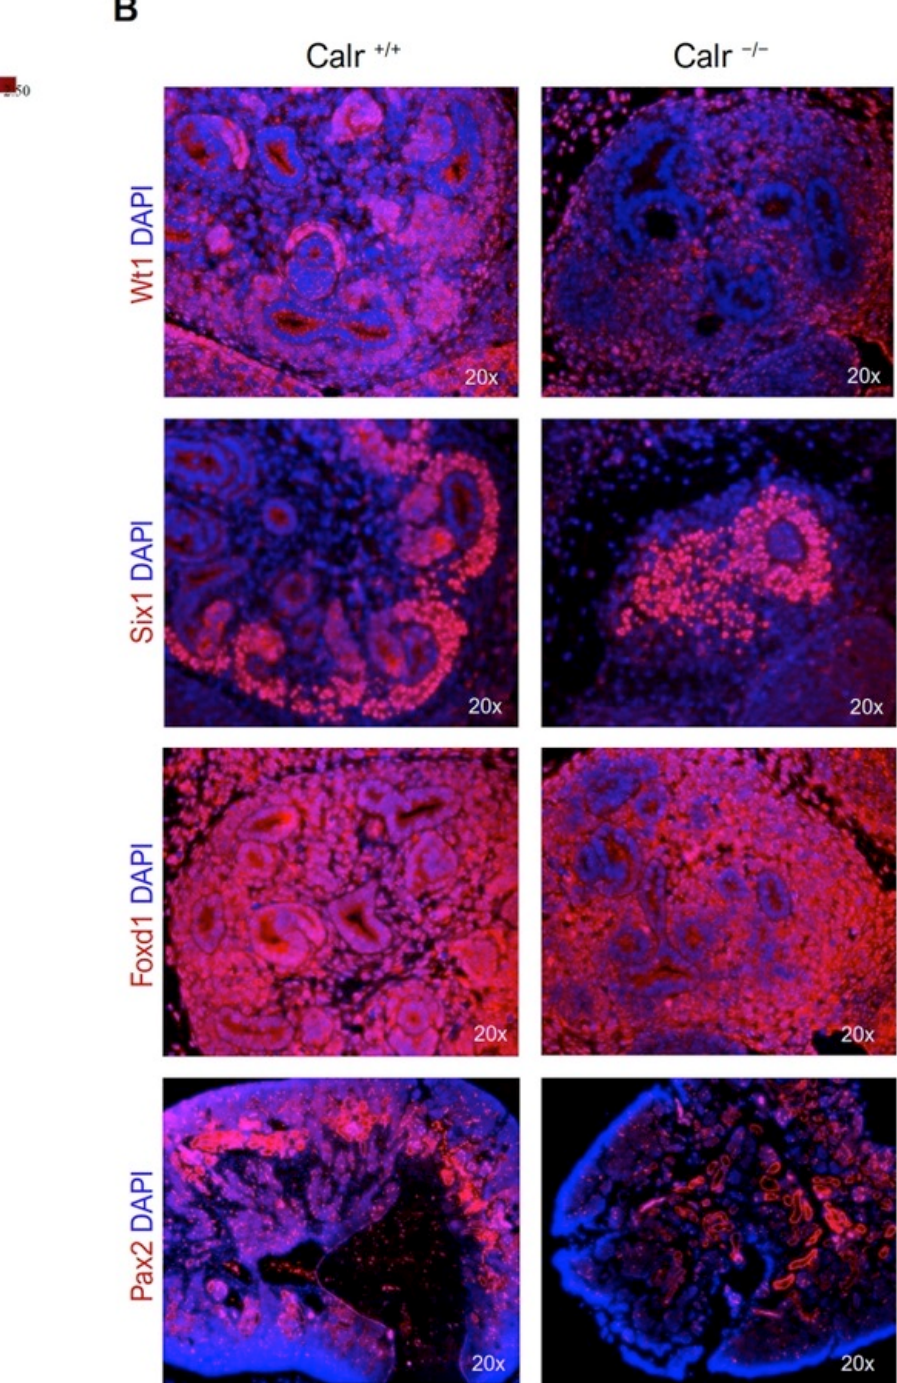
Figure 4. Immunofluorescent staining of sections from the embryonic kidneys. ( A ): Heat map of the essential genes and transcription factors for developmental processes found to be down-regulated in Calr − / − compared to Calr +/+ (FDR < 0.1, FC > 2). ( B ): Embryonic kidneys with three genotypes (Calr +/+ , Calr +/ − or Calr − / − ) were harvested and prepared for immunofluorescence staining. Wt1, Six2, and Pax2 staining was carried out and the slides were subsequently counterstained with DAPI for nuclear visualization on a magnification of 20×.